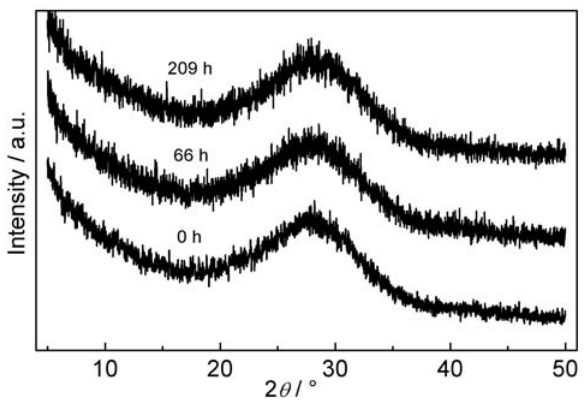
Figure 1. Powder XRD patterns of the solid phase of the systems aged for 0, 66 and 209 h. All patterns were very similar and only 3 representatives (shortest, middle and longest time of aging) we- re shown.